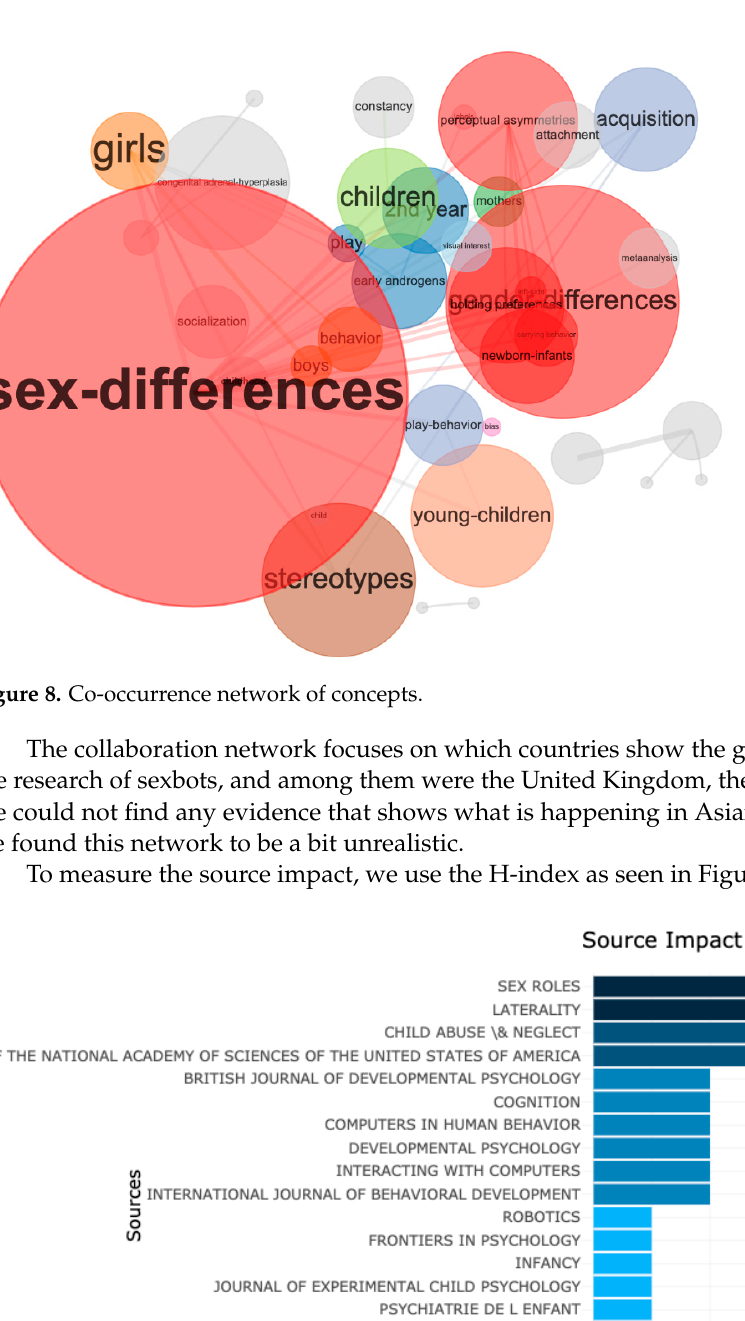
7 of 19 Figure 7. CloudWords with titles of papers found in the review.